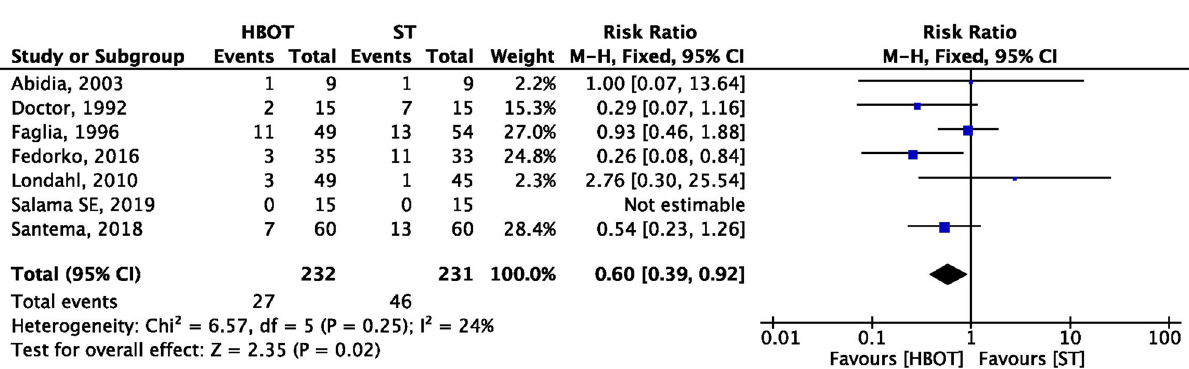
Figure 5. Forest plot of comparison: HBOT versus ST, Outcome: Major